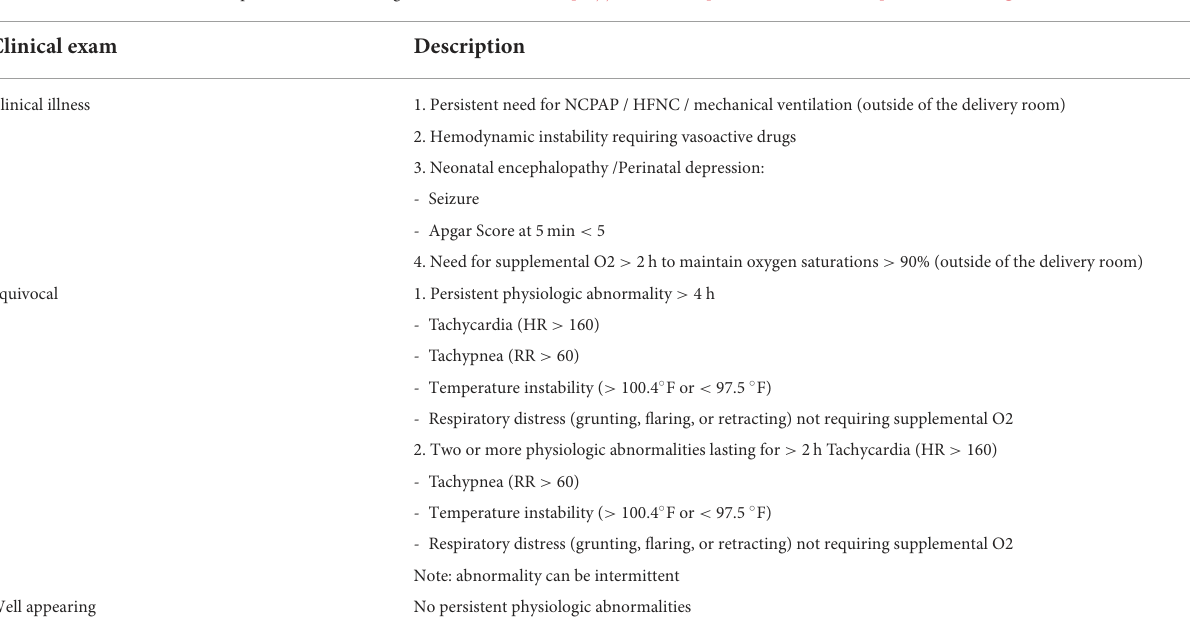
Figure 1 details neonatal symptoms, Apgar scores and the need for respiratory support among symptomatic